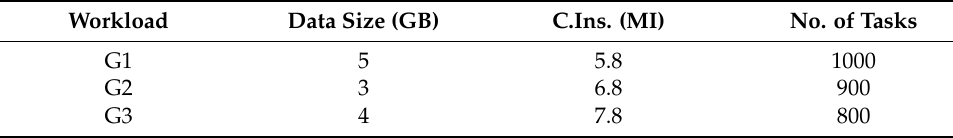
Table 3. Mobile Workflow Workload Analysis. Workload Data Size (GB) C.Ins.